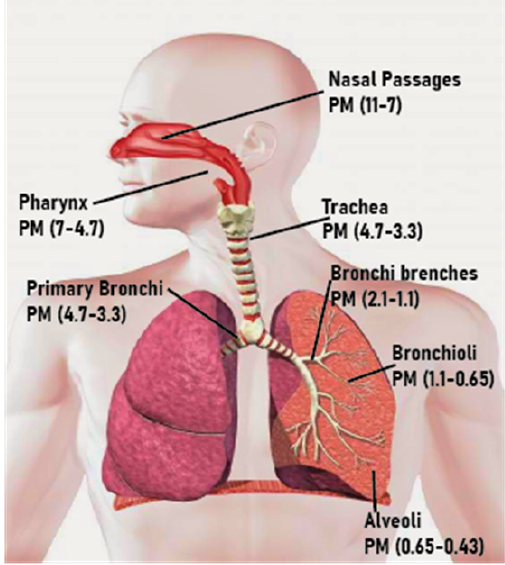
Figure 1. Deposition location of PM particles according to their diameter; adapted from [18].